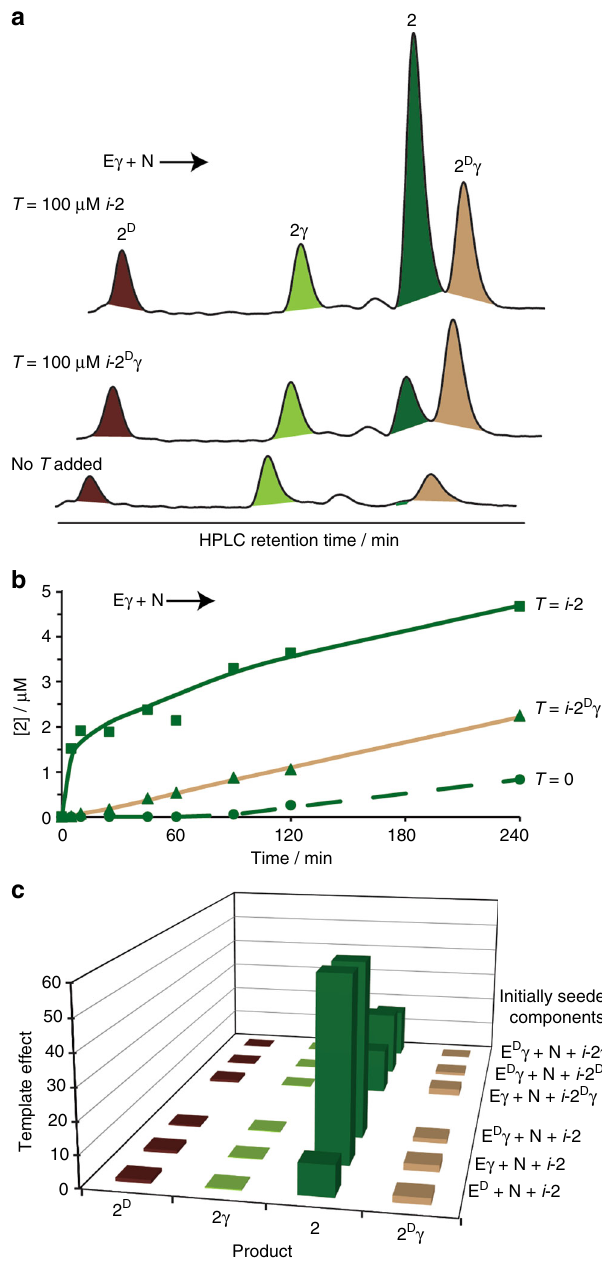
Fig. 7 Template-assisted product formation in reactions initiated with N and each of the non-native electrophile thioesters ( E D , E γ , and E D γ ) separately. a HPLC chromatograms comparing product formation at 90 min in template-free and template-seeded reactions initiated with E γ and N (seeding with i - 2 or i - 2 D γ ). b Time-dependent formation of the native product 2 in template-free and template-seeded reactions initiated with E γ and N . c Bar diagram representing the template effects in reactions initiated with N and each of the non-native electrophile thioesters, separately, and seeded each time with a different template (100 ± 10 μ M). Template effects were calculated from the respective product formation data at 15 min for reactions initiated with E D , and at 90 min for reactions initiated with E γ or E D γ in template-free (Supplementary Fig. 5) and template-assisted ( b of this fi gure and Supplementary Figs. 10 – 12)